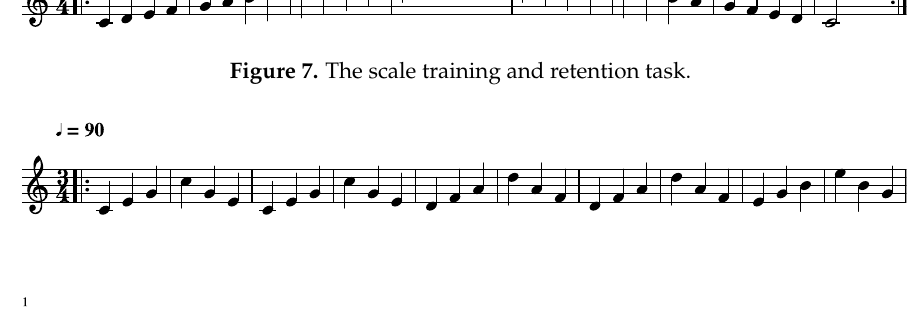
Figure 7. The scale training and retention task.